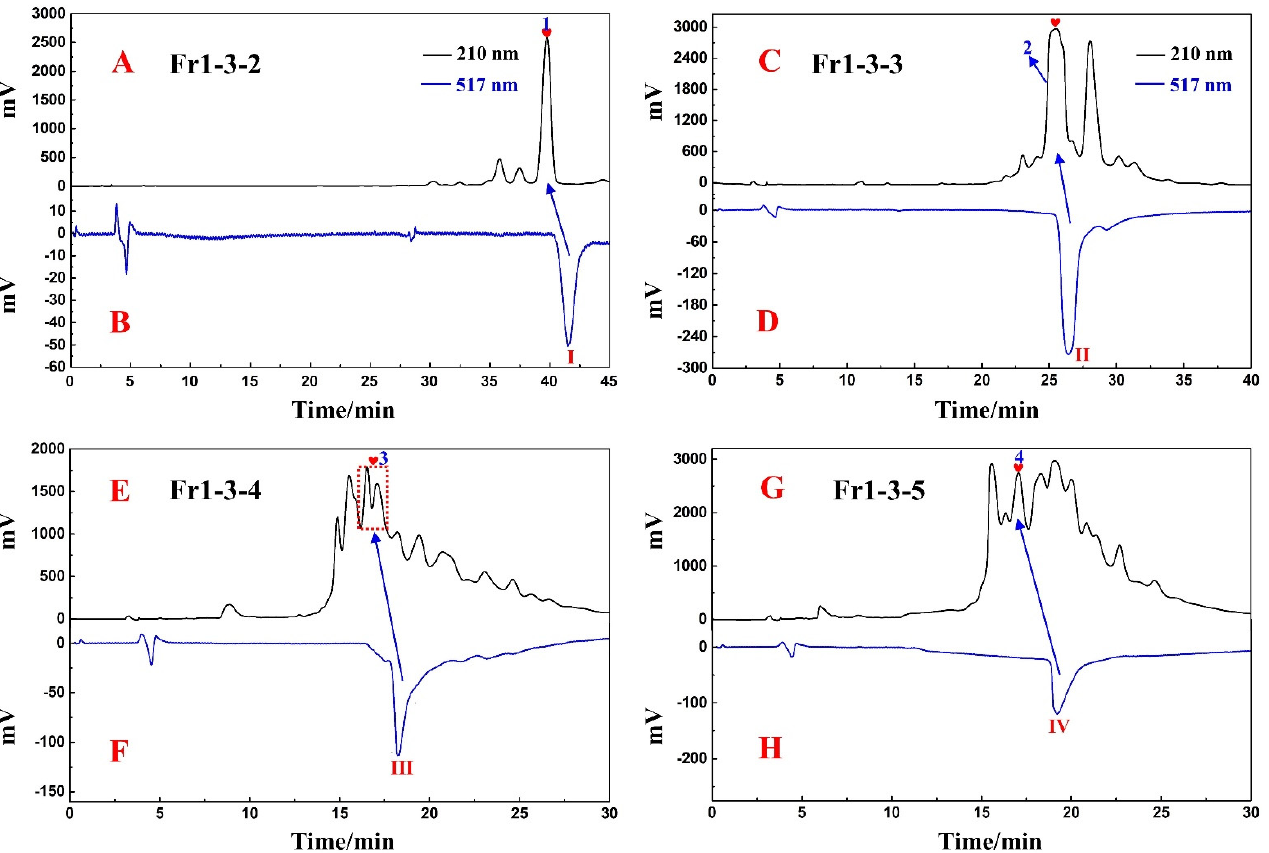
Figure 3. Chromatogram of the Fr1-3-2 verifying the DPPH inhibitory activity ( A , B ), Fr1-3-3 ( C , D ), Fr1-3-4 ( E , F ), Fr1-3-5 ( G , H ) on the ReproSil-Pur C18 AQ analytical column. Conditions for HPLC1